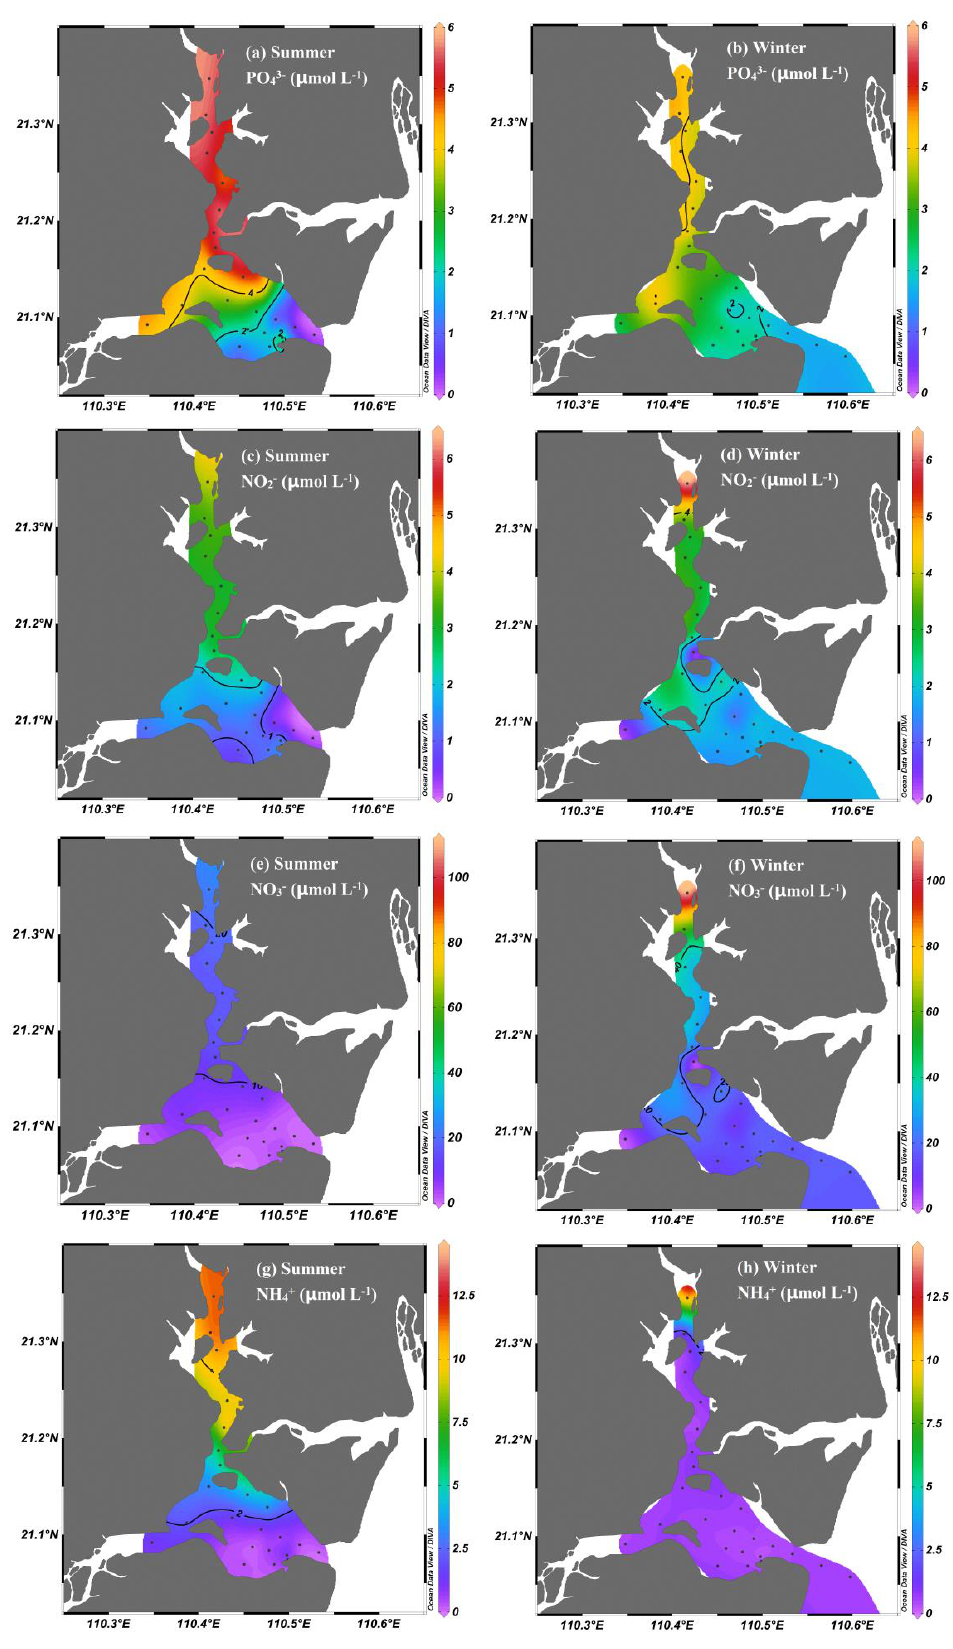
Figure 4. Spatial and seasonal distributions of ( a ) PO 4 3 − , ( b ) NO 2 − , ( c ) NO 3 − , and ( d ) NH 4 + in the surface water in Zhanjiang